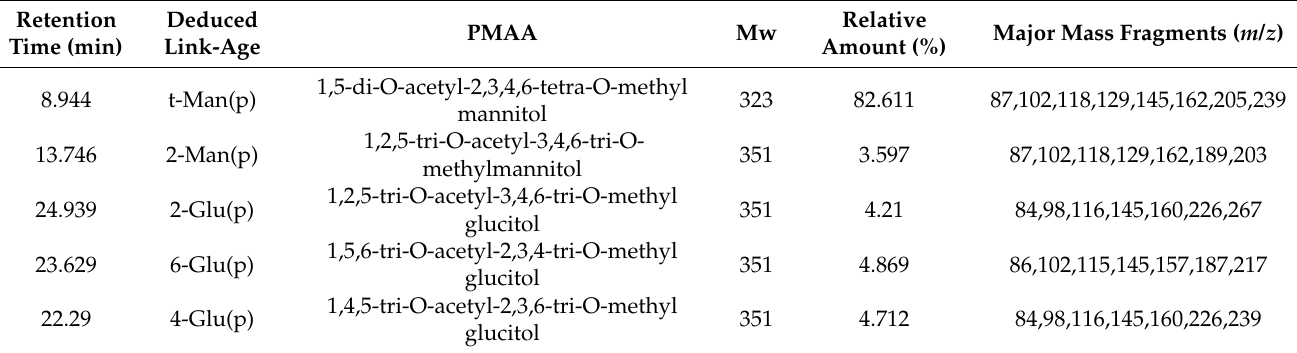
Table 1. Methylation analysis of